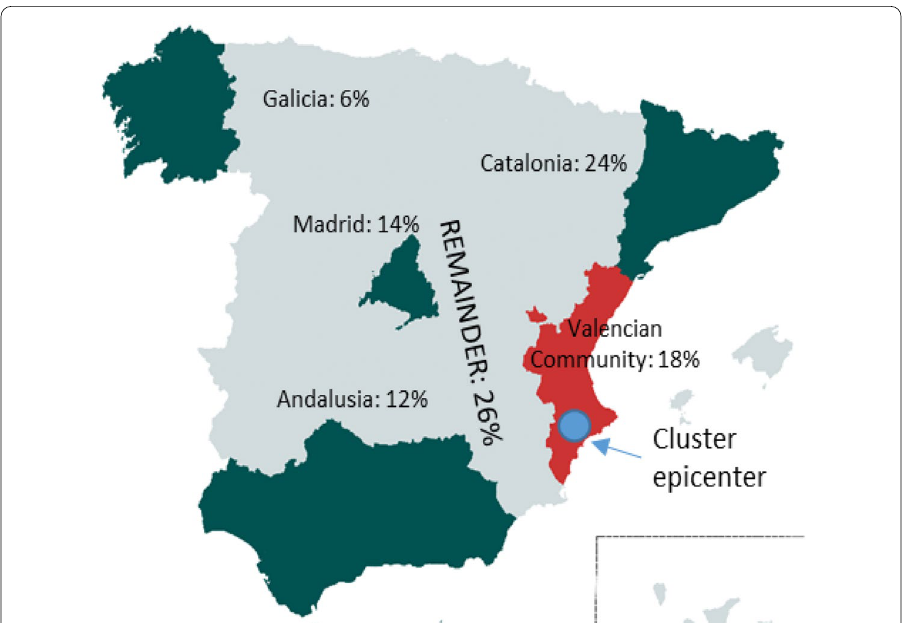
Fig. 1 Geographical concentration of the textile-clothing industry in Spain in 2020. The percentages indicate how many firms are located in each area. Valencian Community agglomerated 18% of the total. The data were obtained from SABI; the map and representation are